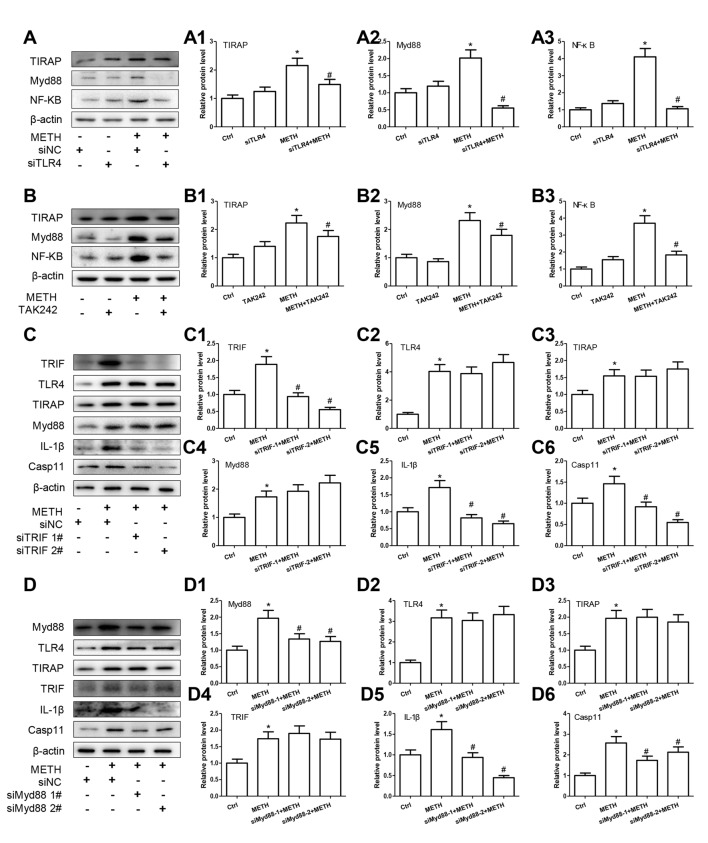
TLR4 mediates METH-induced IL-1β and IL-18 expression through both Myd88-dependent and Myd88-independent signaling pathways. Primary cultured astrocytes transfected with siRNAs targeting TLR4 (A–A3), TRIF (C–C6), Myd88 (D–D6) or control siRNA for 24 h followed by METH (2 mM) treatment for 24 h. Cells were exposed to TAK-242 (100 nM) (B–B3) for 2 h prior to METH (2 mM) treatment as indicated. Western blot (A–D) and quantitative analyses were performed to determine TLR4, TRIF, TIRAP, Myd88, NF-κB, Caspase-11 and/or IL-1β protein expression. All the experiments were repeated three times. Data are expressed as mean ± SD. *p < 0.05 vs. non-METH-treated group. #p < 0.05 vs. the scrambled + METH treated group. Data in (A,B) were analyzed with 2 × 2 factorial ANOVA followed by LSD post hoc analyses; data in (C,D) were analyzed with two-way ANOVA followed by LSD post hoc analyses.